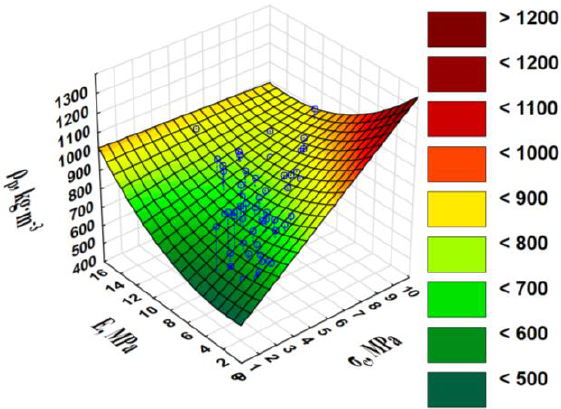
Figure 4. Single pellet density ρ p vs. pellet tensile strength σ c and elasticity modulus for pellet compression E .